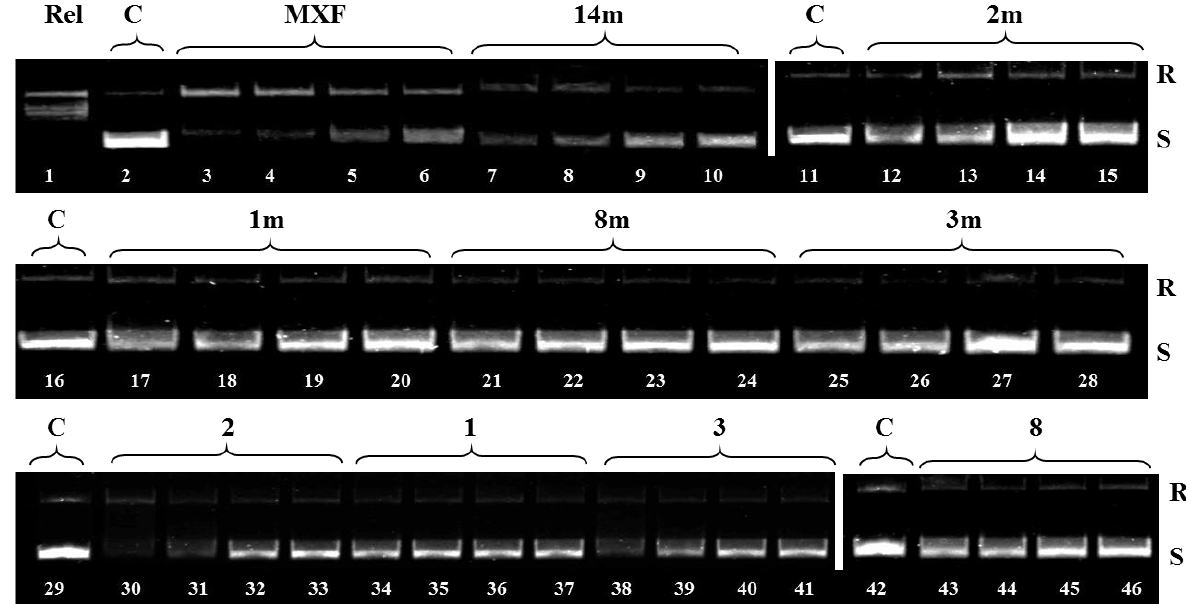
Table 5. IC 50 values for the inhibition of catalytic activities of S. aureus topoisomerases.